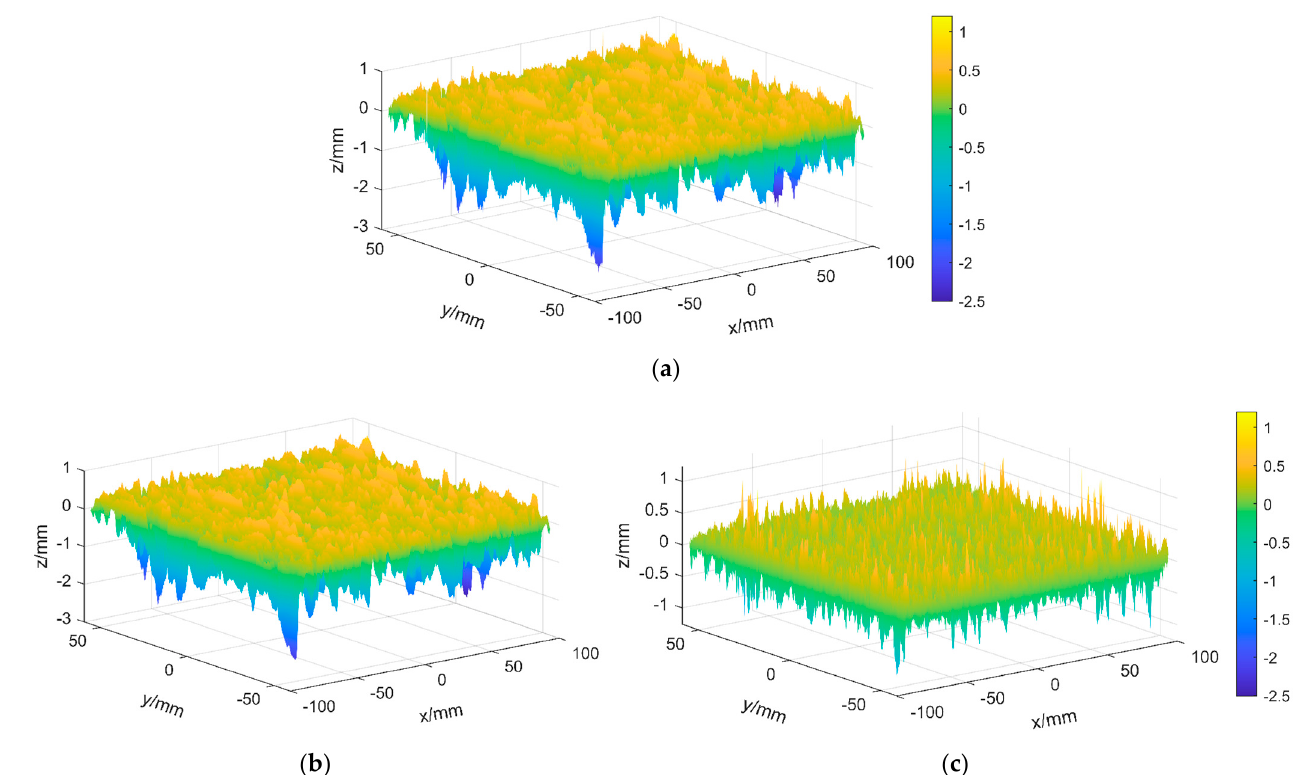
Figure 9. Comparison before and after texture separation. ( a ) Original texture. ( b ) Macro-texture. ( c ) Micro-texture.